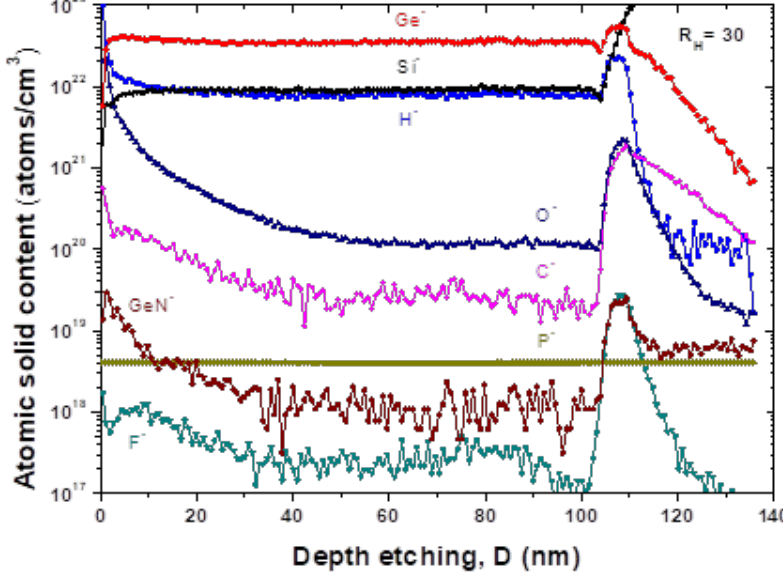
Figure 2. SIMS depth profile of H-, C-, O-, F-, Si-, P-, Ge-, GeN- elements in silicon–germanium film (R H = 30) grown on p + -doped c-Si wafer.